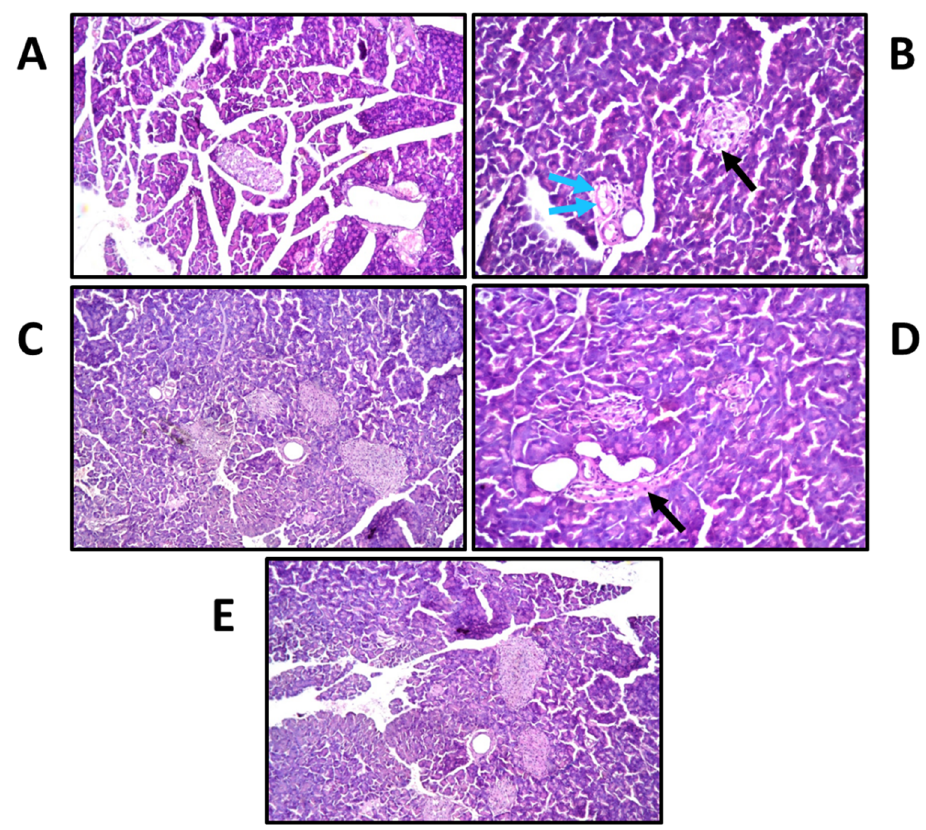
Figure 8. Histopathology of rat pancreatic tissue stained with hematoxylin and eosin determined by light electric microscopy (× 40); ( A ): normal control revealing normal histological structure of cells; ( B ): diabetic control demonstrated atrophy (Black arrows), oedema (Blue arrows), and a drastic decrease in the number of the islets of Langerhans cells; ( C ): diabetic + drug suspension exhibited a remarkable recovery; ( D ): diabetic + unmedicated nanosystem resulted in atrophy (Black arrows) and regression in the size contour of the islets of Langerhans cells; and ( E ): diabetic + medicated nanosystem, revealing no histopathological alteration in the islets of Langerhans cells compared to normal control.